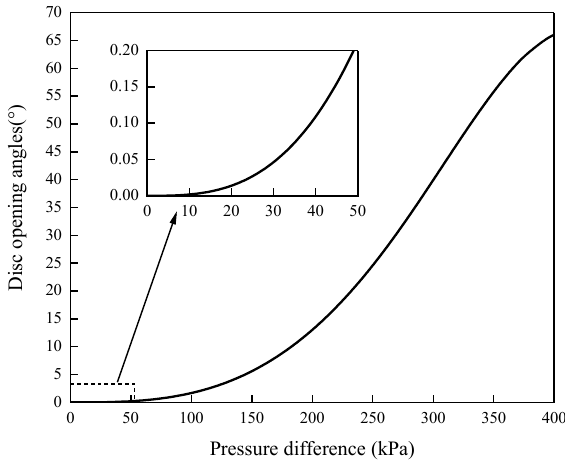
Figure 22. Optimized valve disc opening angle and pressure difference curve.